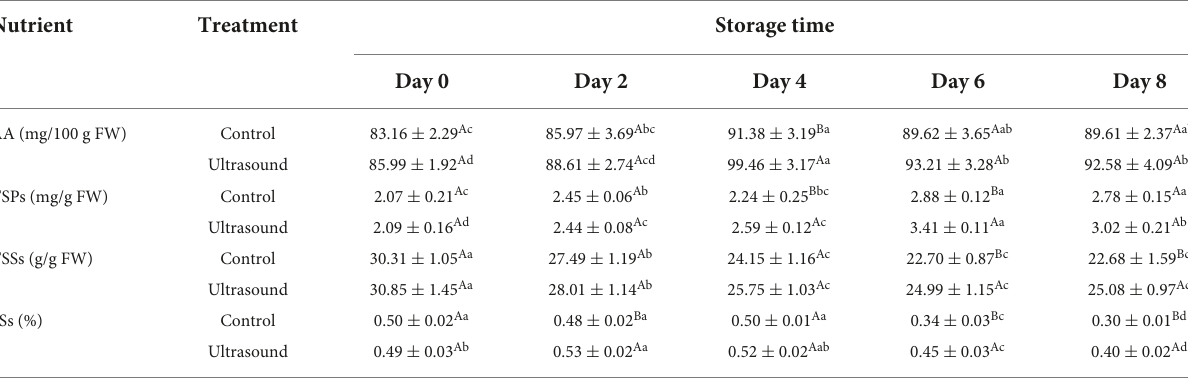
TABLE 2 Effects of ultrasonic washing on the contents of ascorbic acid (AA), total soluble proteins (TSPs), total soluble sugars (TSSs), and total soluble solids (SSs) in fresh-cut red cabbages during 4 ◦ C storage.